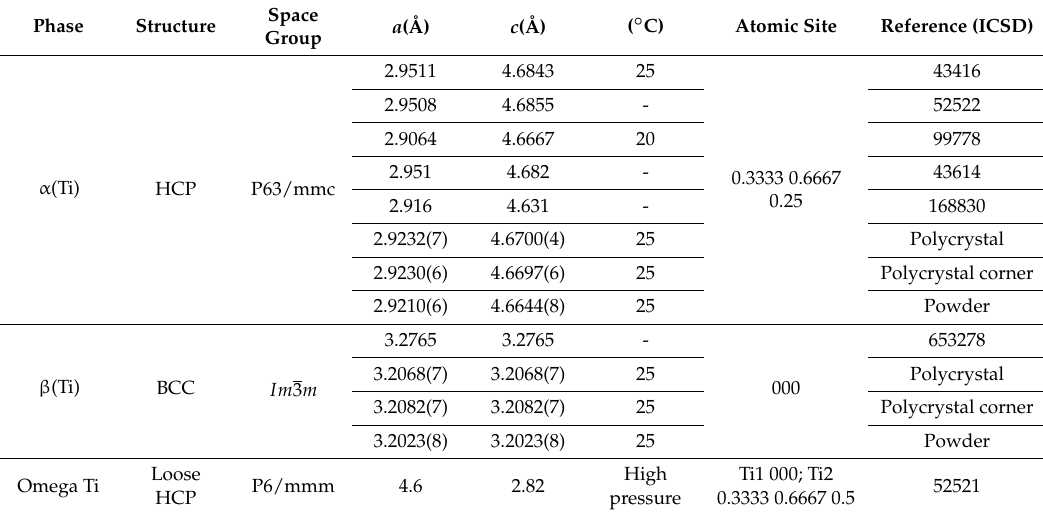
Table 2. Some known and calculated crystallographic information of different Ti